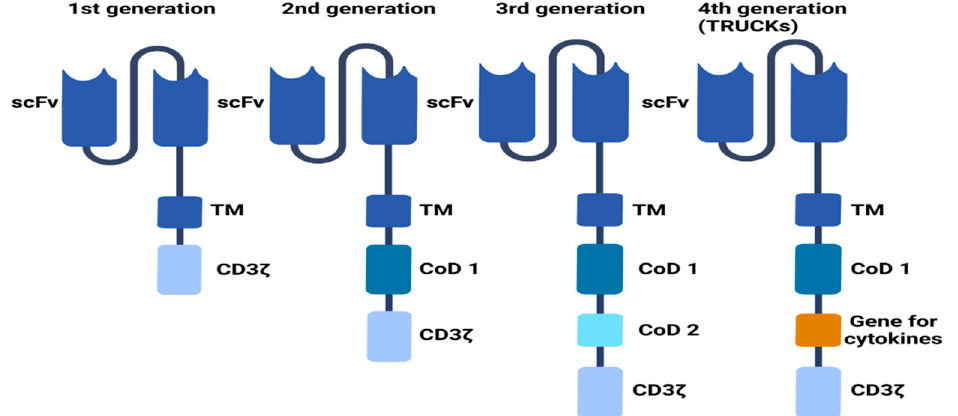
Figure 2. Generations of CAR-T cells. 1st generation of CAR-T cells is based on the presence of the intracellular CD3 ζ domain. 2nd generation incorporates an additional costimulatory domain (CoD), mostly CD28. 3rd generation contains two costimulatory domains, e.g., CD28, ICOS, 4-1BB, or OX40. These domains activate multiple signaling pathways. This provides a more effective approach to aiming to destroy cancer cells. 4th generation (also called TRUCKs) is based on the second generation with an additional gene responsible for cytokine expression in the cell microenvironment [11,21–27].